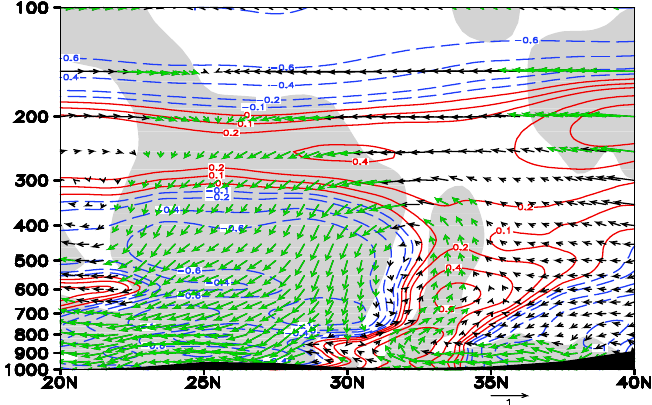
Figure 8. Composite difference of vertical circulation (vectors; unit: m·s − 1 horizontal winds and ×0.05 Pa·s − 1 for vertical p-velocity) and pseudo-equivalent temperatures (contours; unit: K) along 115° E between the periods 1990–1999 and 2000–2009. Gray shadings denote the anomalous vertical circulation significant at the 90% confidence level (green wind vectors). Black shadings denote the terrains. Red solid contours denote the differences in pseudo-equivalent temperatures greater than or equal to 0, and blue contours denote those less than